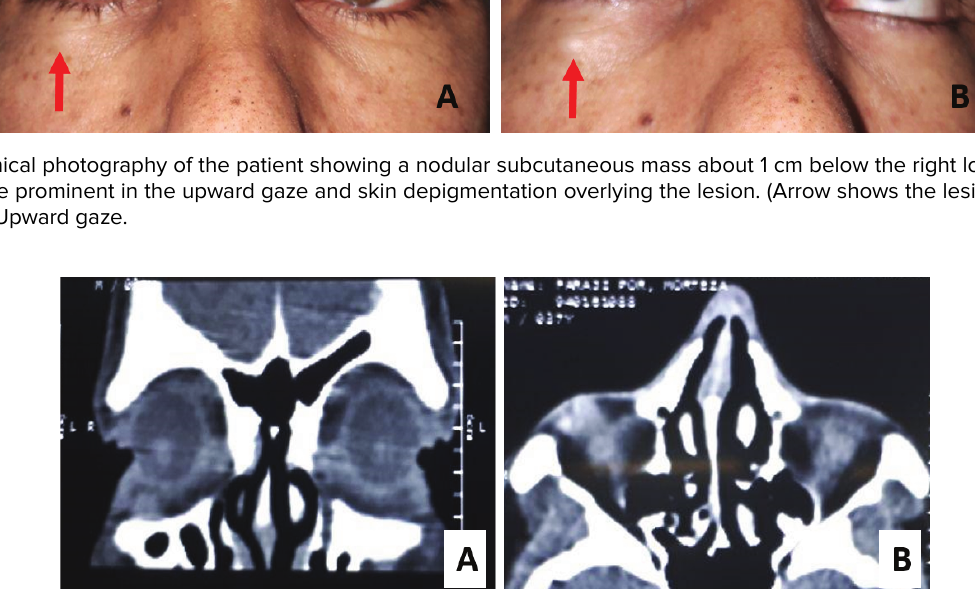
Figure 2. Orbital CT scan shows a well-defined mass in the inferotemporal extraconal space of the right orbit which has a single lobe posteriorly and changes to bilobed anteriorly. (A) Coronal view of the anterior orbital space. (B) Axial view of the inferior orbital